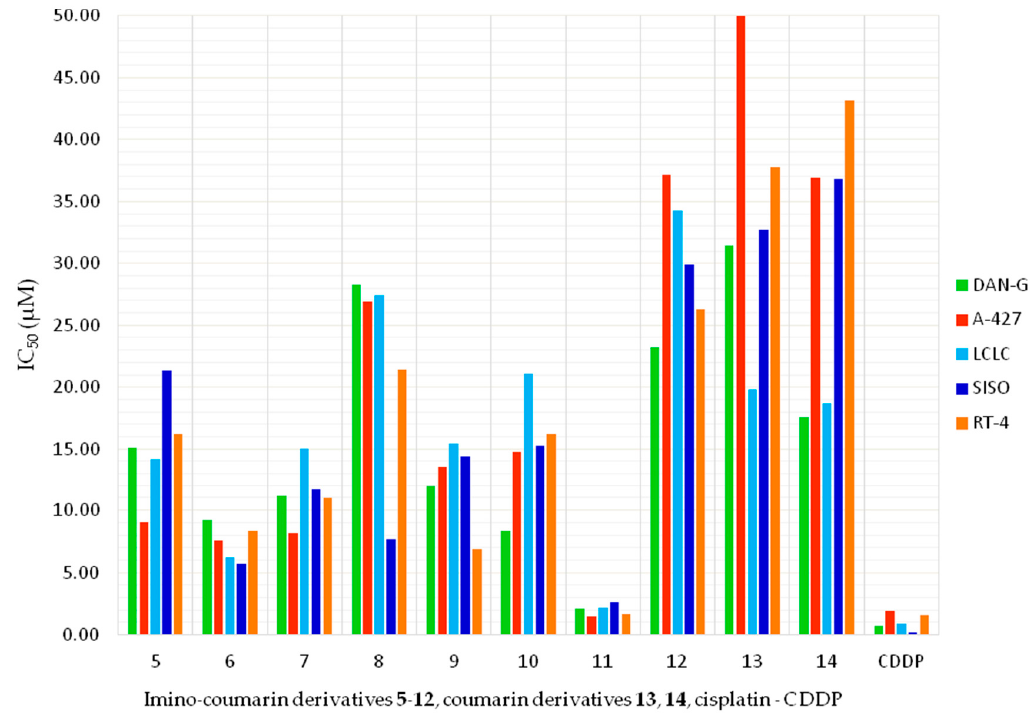
4. IC 50 ( µ M) values of 2-imino-2H-chromen-3-yl-1,3,5-triazines 5 – 12 and Figure 4. IC 50 ( μ M) values of 2-imino-2 H -chromen-3-yl-1,3,5-triazines 5 – 12 and 2 H -chromen-3-yl- 2 H -chromen-3-yl-1,3,5-triazines 13 , 14 on five human tumor cell lines (DAN-G, A-427, LCLC, 1,3,5-triazines 13 , 14 on five human tumor cell lines (DAN-G, A-427, LCLC, SISO, RT-4) compared to SISO, RT-4) compared to cisplatin cisplatin (CDDP).